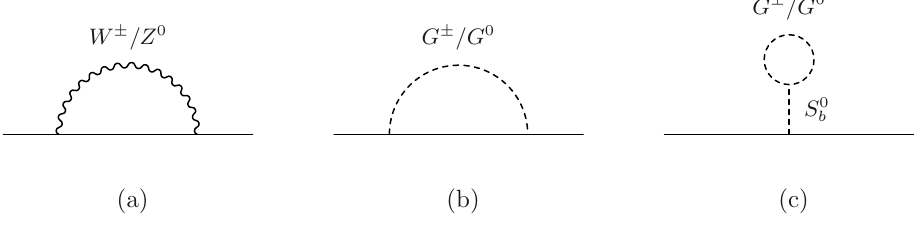
Figure 4. Loop contributions to the fermion self-energies that depend on ξ . In diagram (c) only physical neutral scalars contribute, i.e. b = 2 , . . . , 2 n H